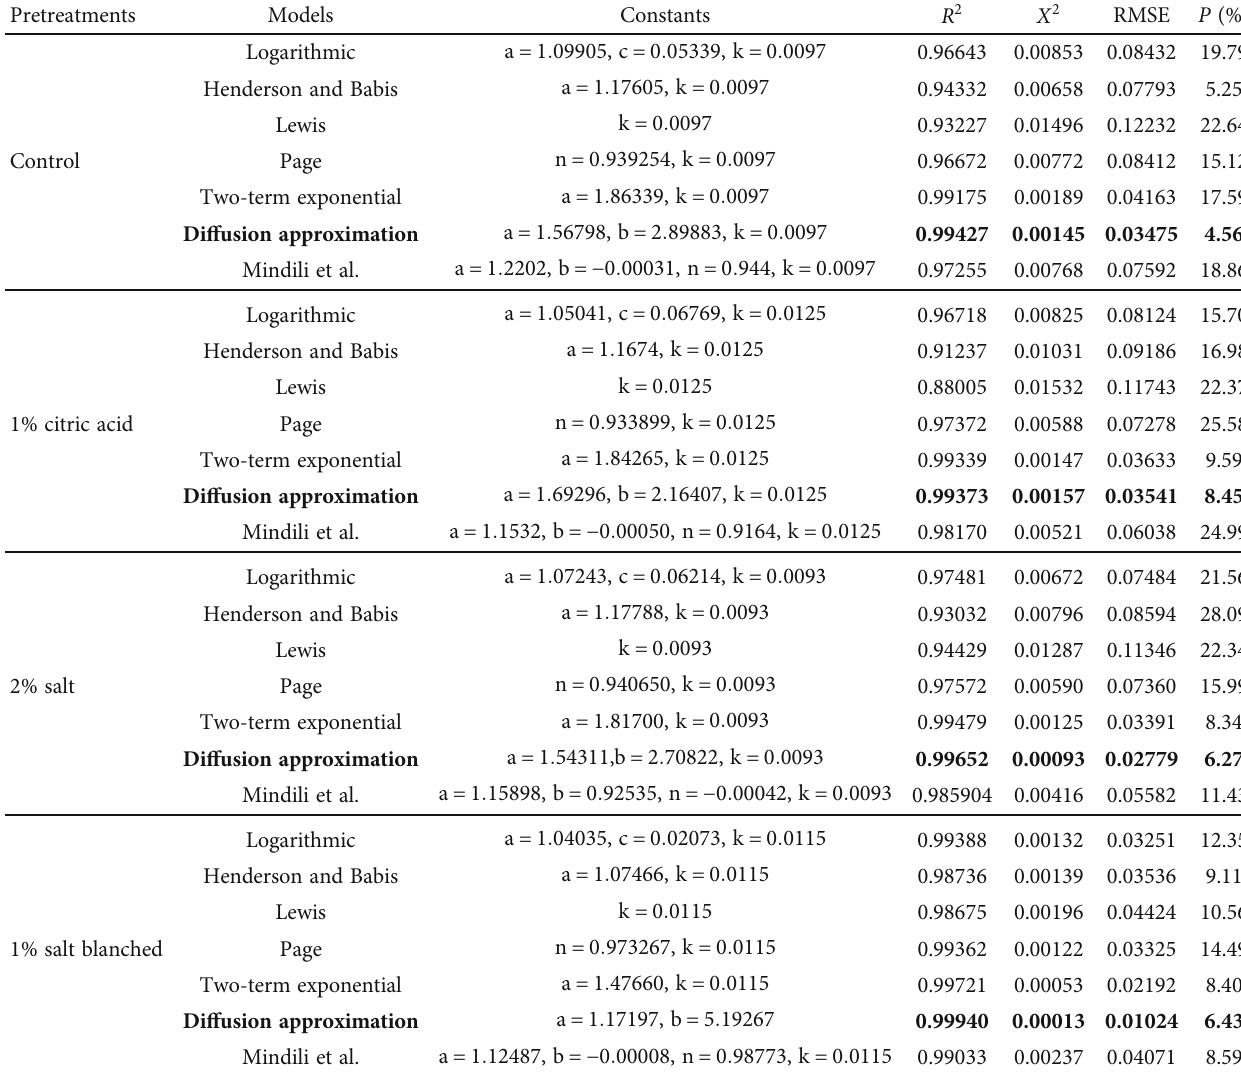
Table 6: Curve fi tting criteria for the various mathematical models for pumpkin pretreated and dried at temperatures of zone II.